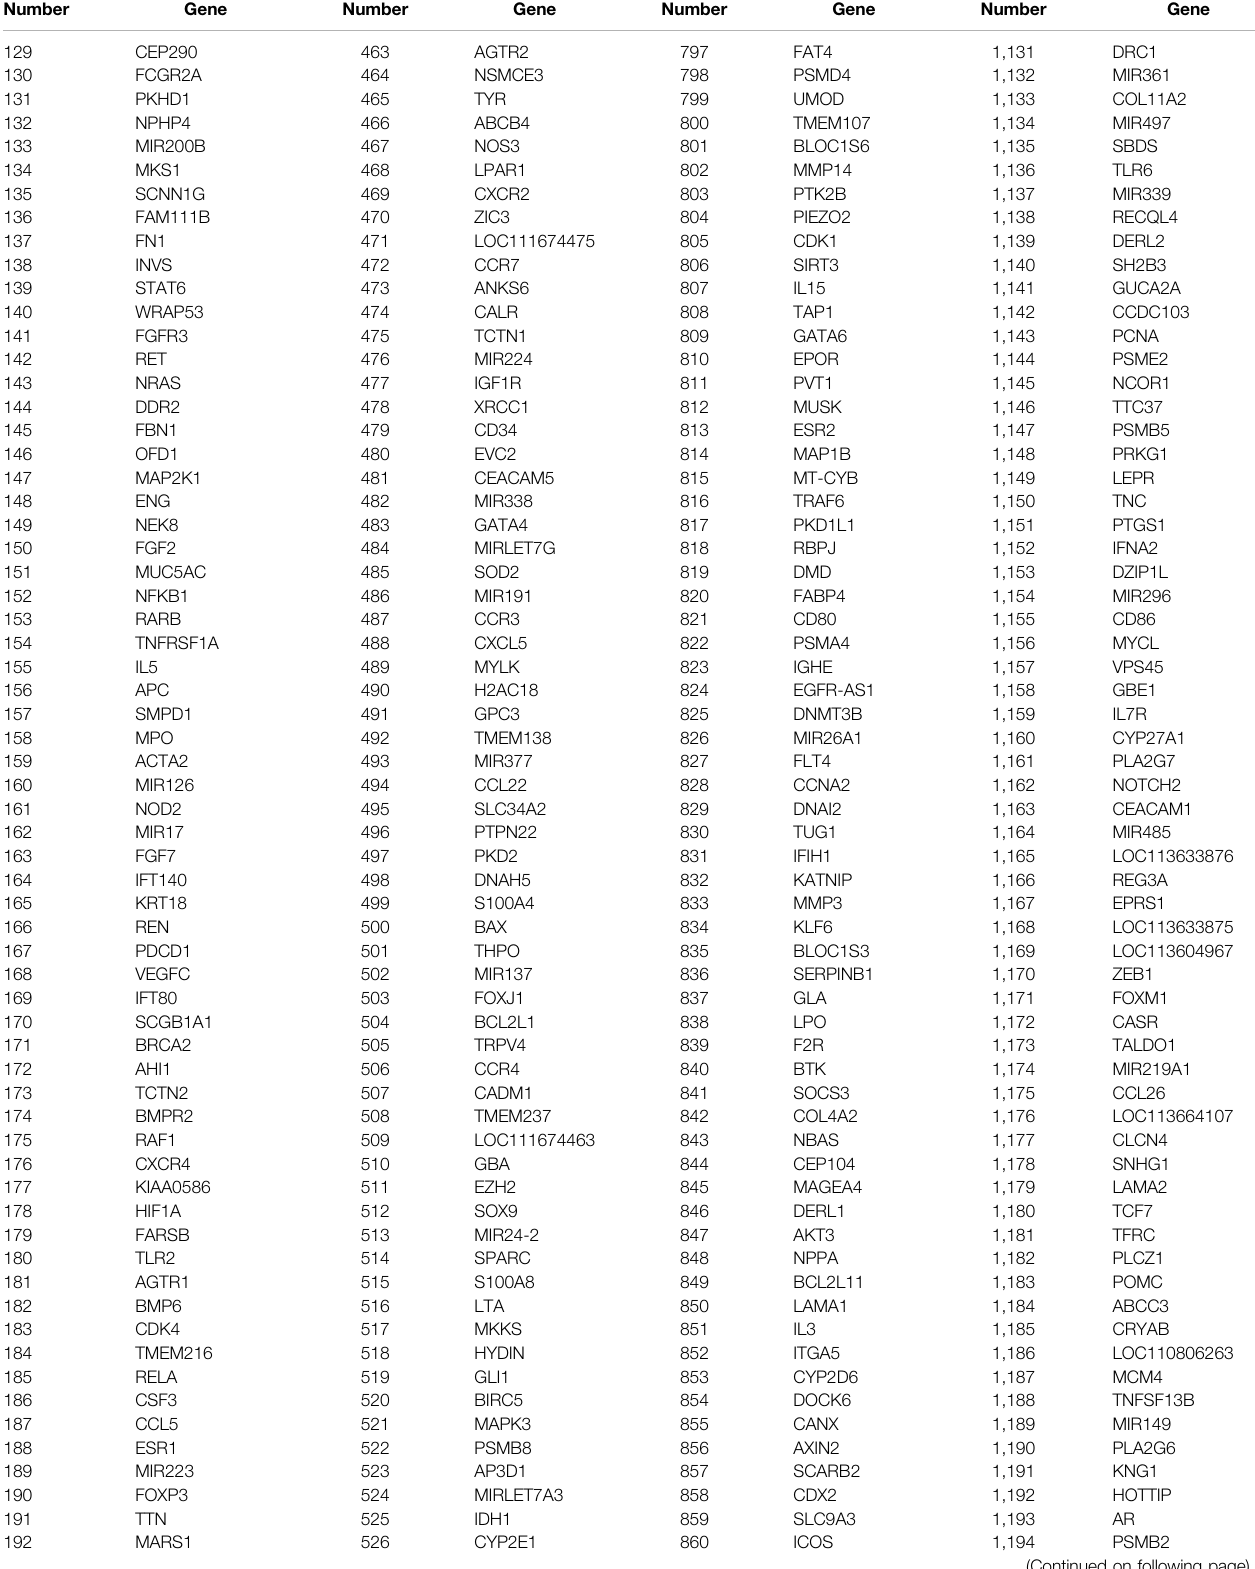
TABLE 3 | ( Continued ) Lung fi brosis-related targets obtained from the GeneCards